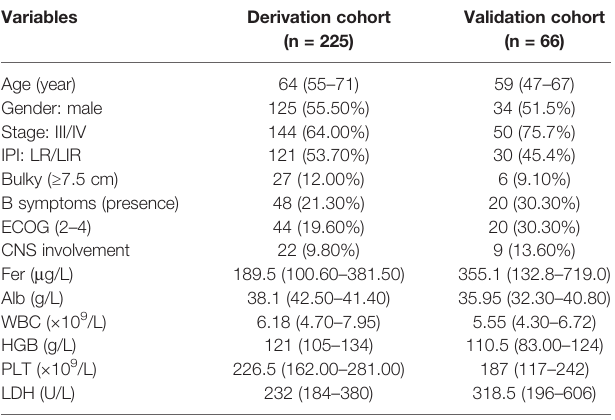
TABLE 1 | Characteristics of DLBCL patients in two cohorts.